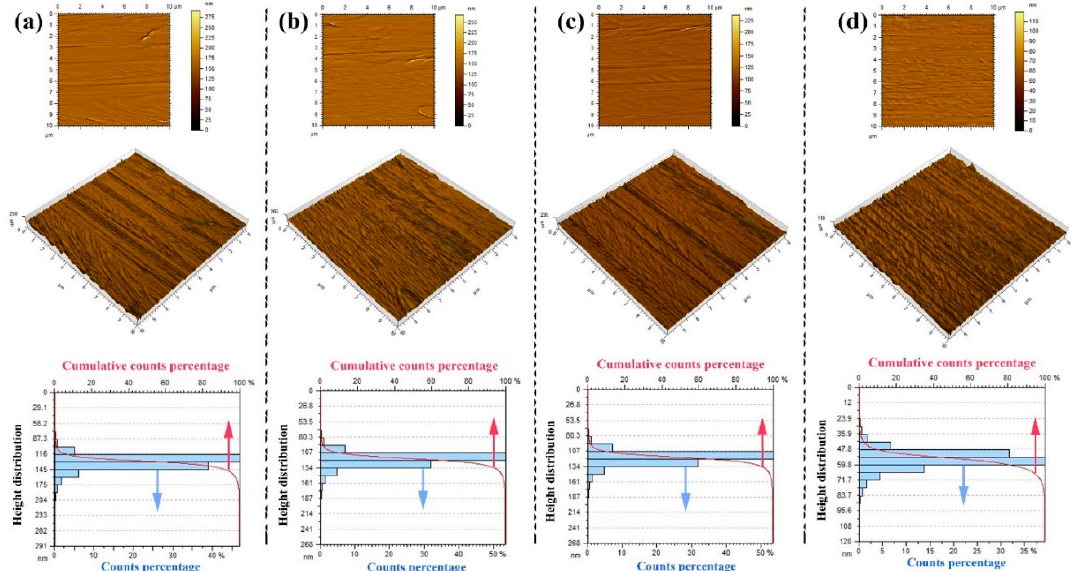
Figure 7. Surface topography analysis of SS films on SS 316L substrates, where ( a ) 2D and 3D rendered AFM topograph and height distribution of the surface of the uncoated SS 316L substrate, and ( b – d ) 2D and 3D rendered AFM topograph after 50, 100, and 150 nm SS deposition on substrates and their height distribution. Table 3. Height parameters of the AFM analysis of the uncoated, 50 nm, 100 nm, and 150 nm coated SS substrates.